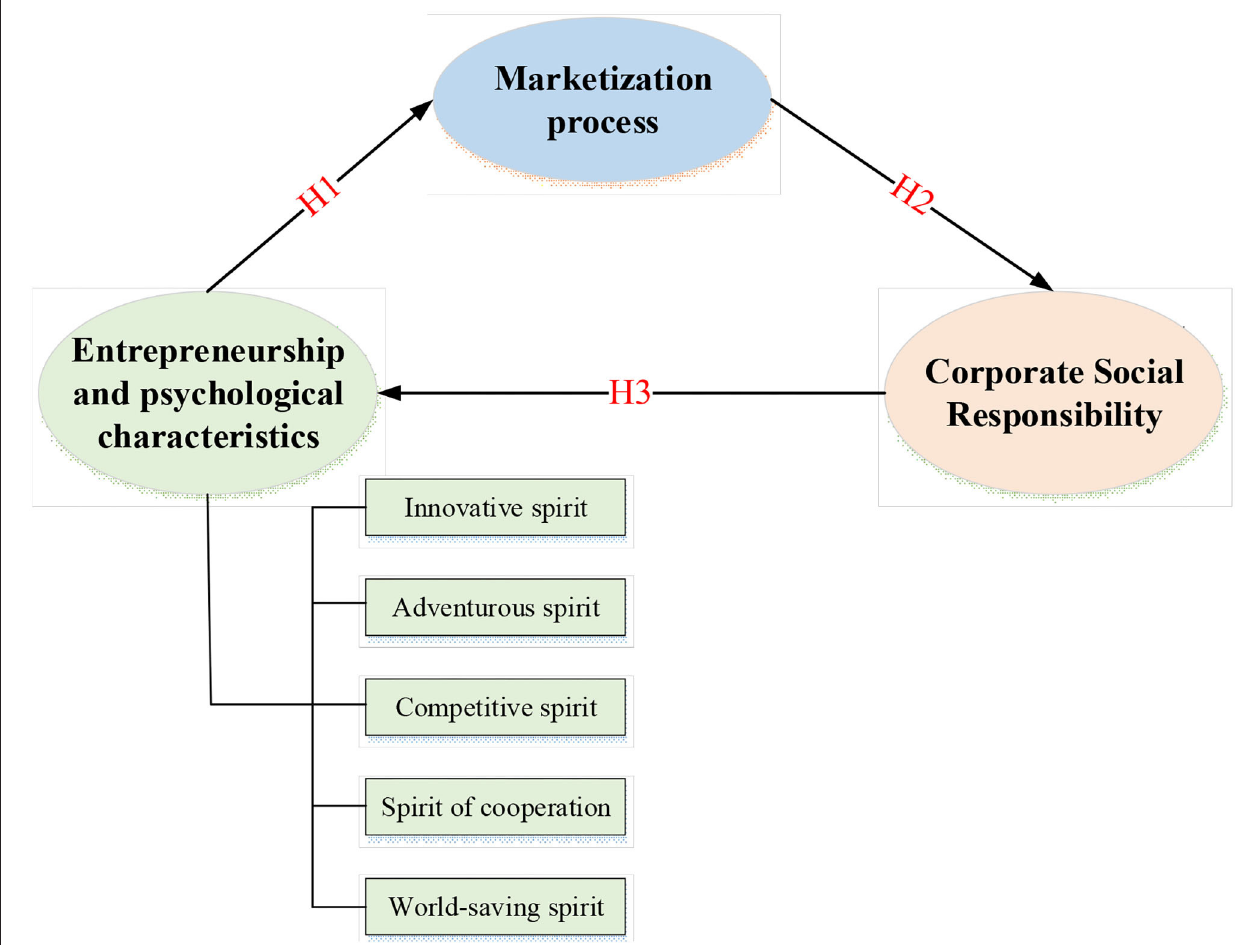
FIGURE 1 | Relationship model of entrepreneurship and psychological characteristics, marketization process, and corporate social